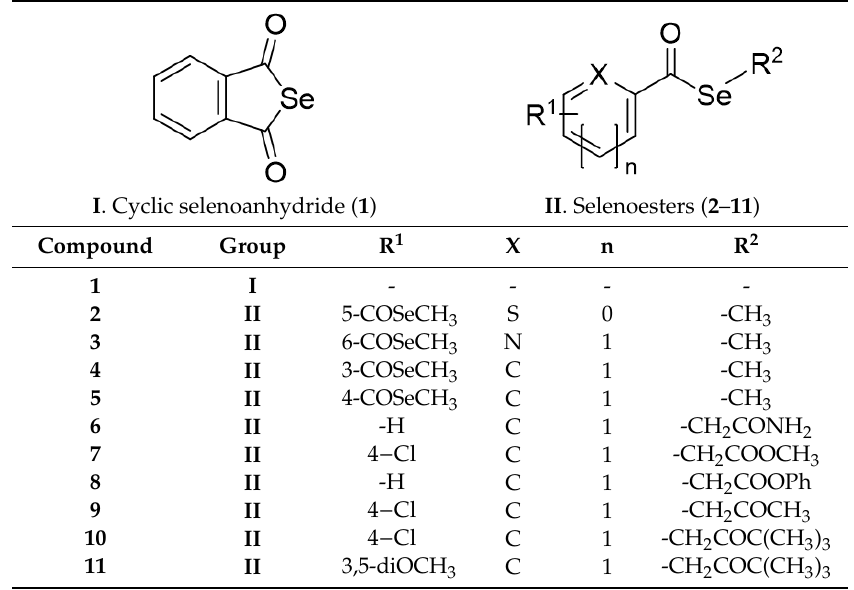
Table 1. Selenocompounds evaluated as antibacterial and as multidrug resistance reversing agents—selenoanhydride ( 1 ) and selenoesters ( 2 – 11 ).